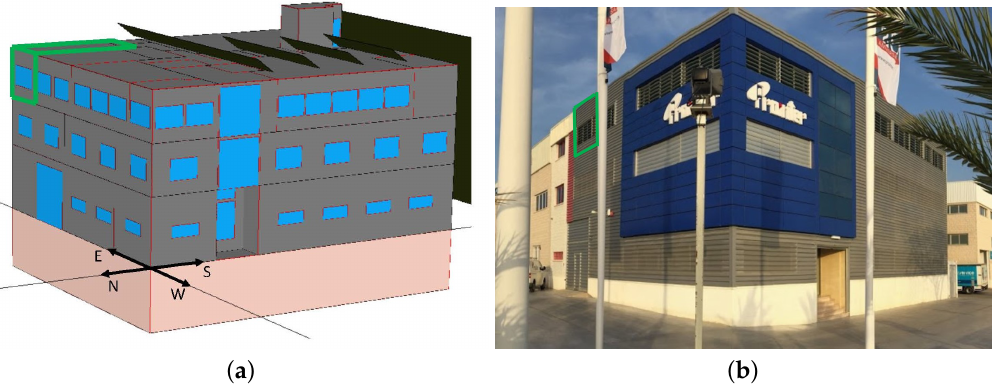
Figure 2. ( a ) Building model generated with the HULC computer tool. ( b ) Real building